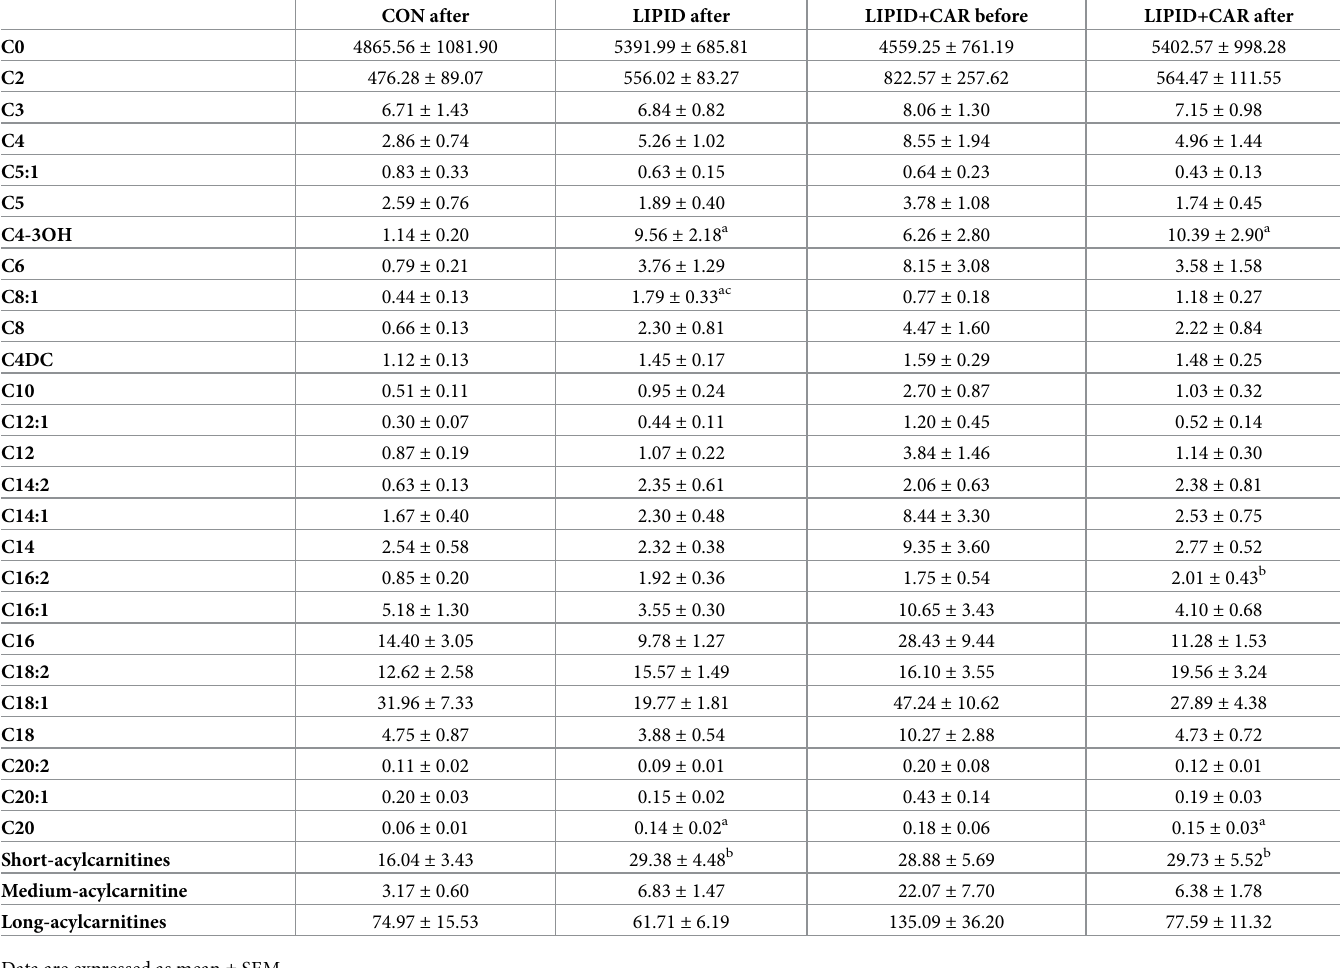
Table 4. Skeletal muscle acylcarnitine concentrations (in biopsies) before (only LIPID+CAR trial) and after the 6-hour hyperinsulinemic-euglycemic clamp. CON after LIPID after LIPID+CAR before LIPID+CAR